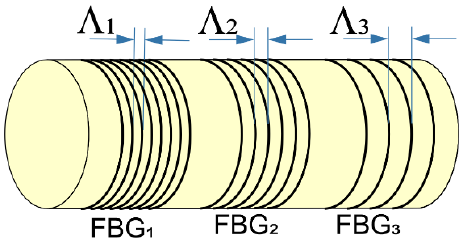
Figure 1. Optical fiber segment comprising three FBGs with increasing period.